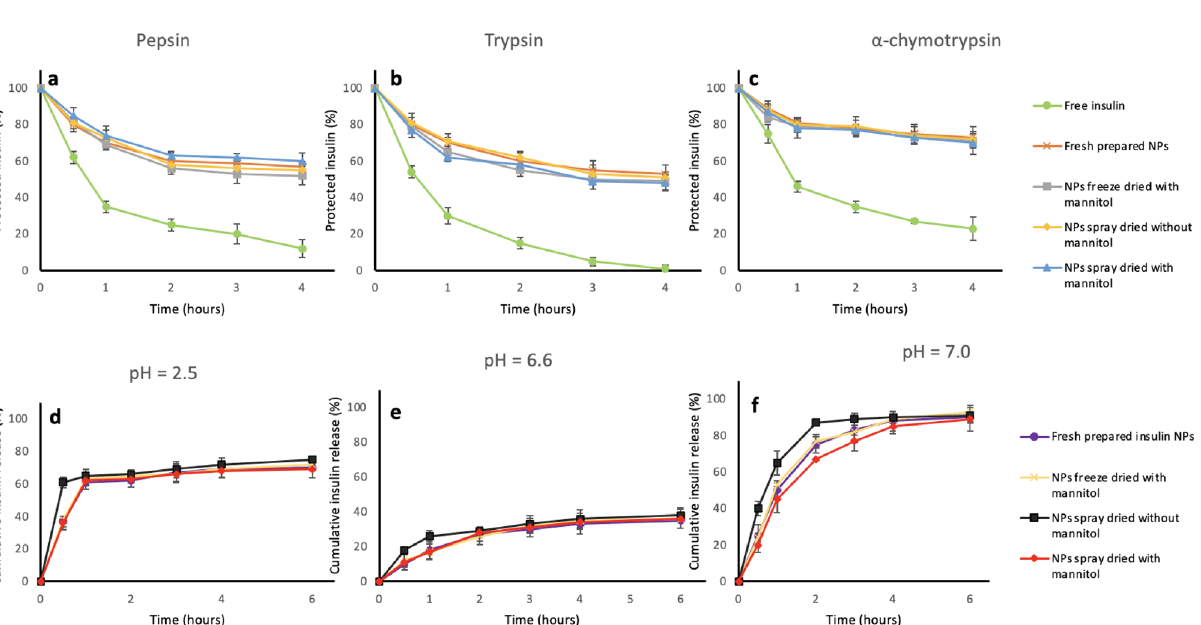
Figure 5. Protection effects and release behaviors of dehydrated insulin NPs: ( a ) Protection of insulin at pepsin solution; ( b ) Protection of insulin at trypsin solution; ( c ) Protection of insulin at α-chymotrypsin solution; ( d ) Release behaviors of dehydrated NPs in pH = 2.5 solutions; ( e ) Release behaviors of dehydrated NPs in pH = 6.6 solutions; ( f ) Release behaviors of dehydrated NPs in pH = 7.0